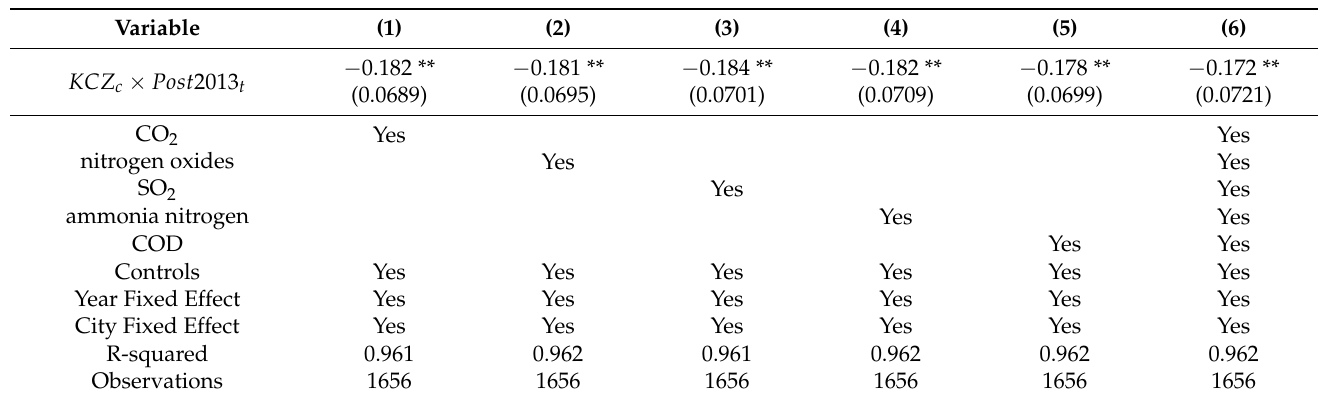
Table 4. Other simultaneous policies.